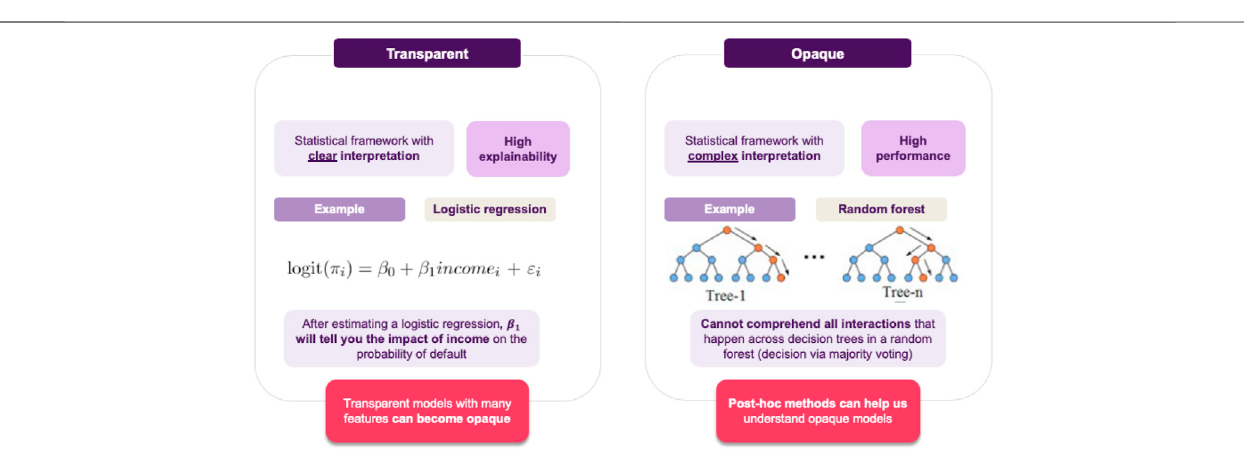
Frontiers in Big Data |